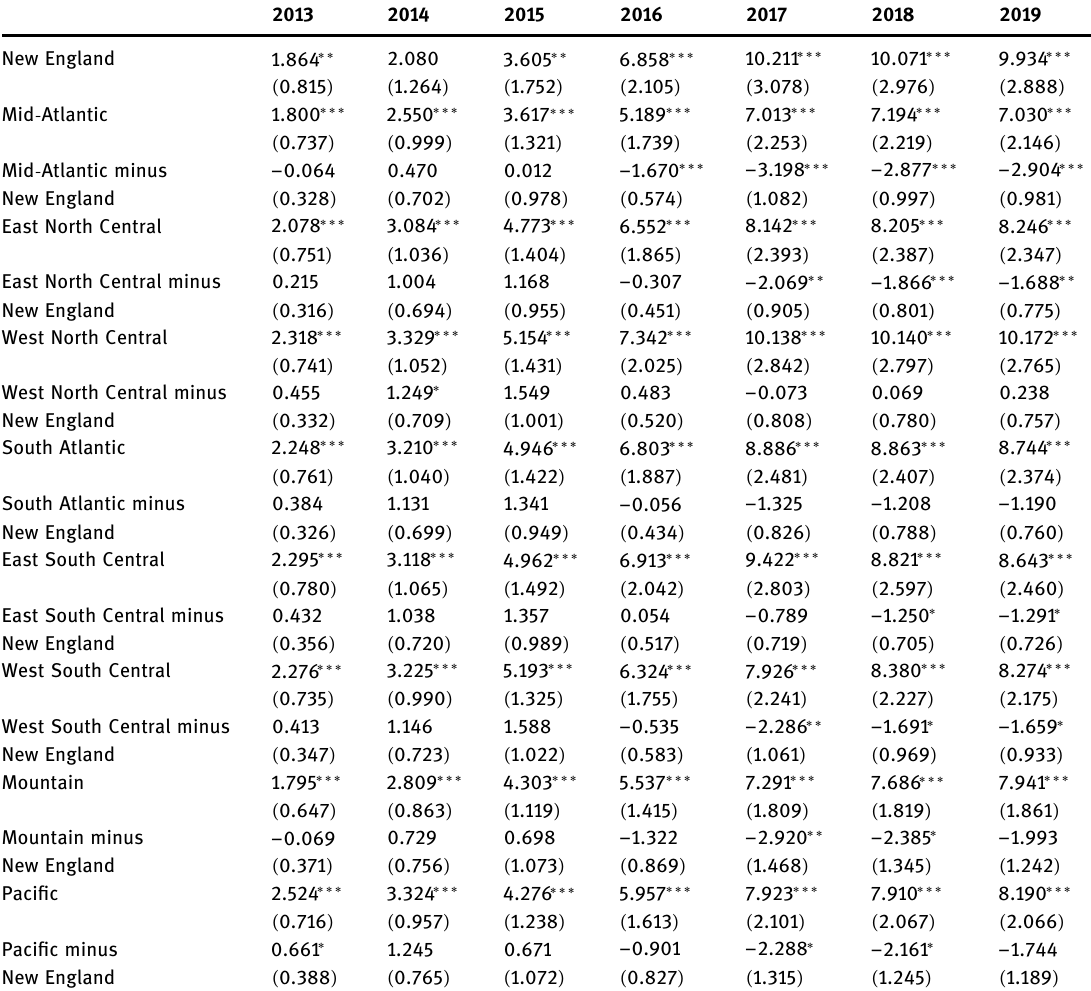
Table 8: E ff ect of pay - for - performance as (